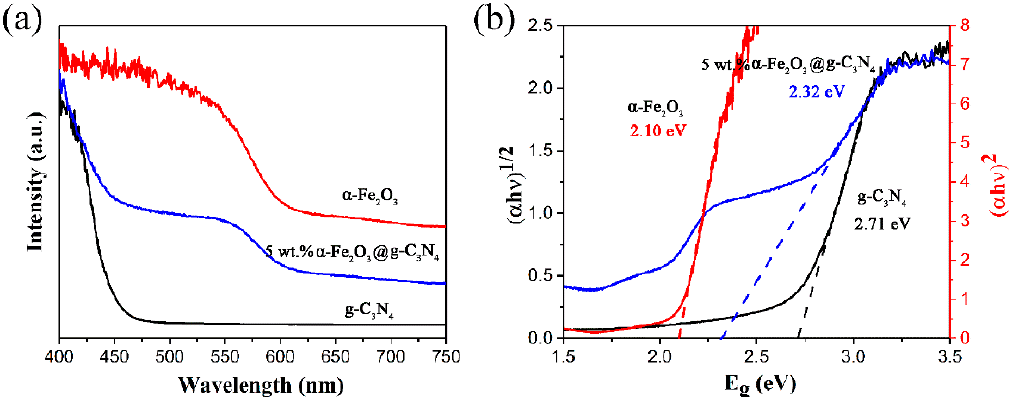
Figure 3. ( a ) UV-vis diffuse reflectance spectra (UV–vis DRS) of different samples, ( b ) plots of the (ah ν ) 1/2 versus photon energy (hv) for g-C 3 N 4 and 5 wt.% α -Fe 2 O 3 @g-C 3 N 4 photocatalyst; plots of the (ah ν ) 2 versus photon energy (hv) for α -Fe 2 O 3 .